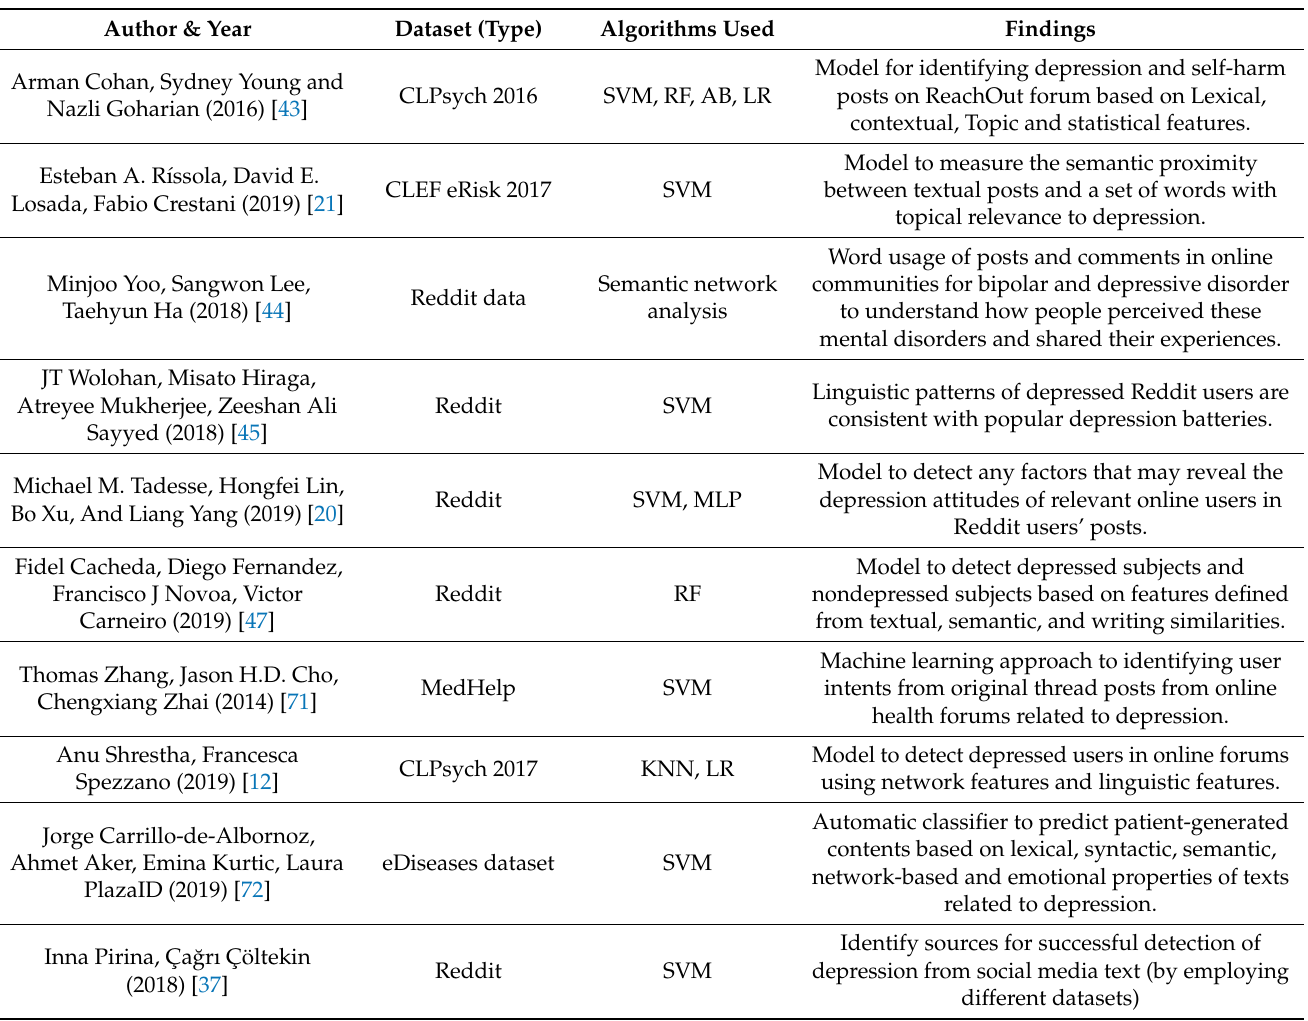
Table 2. Matrix of the summary of findings in depression identification using online support forum data; Moreover similar techniques were applied when analysing online forum textual contexts (Support Vector Machines = SVM, Logistic Regression = LR, Random Forest = RF, Ada Boosting = AB, Multinomial Naive Bayes = MNB, K-nearest neighbor = KNN, Passive Aggressive Classifier = PAC, Stochastic Gradient Descent = SGD, Neural Network = LSTM, Multi- layer Perceptron = MLP, Conventional Neural Network = CNN, Long Short Term Memory = LSTM, Gradient Boosting = GB, Bagging Predictors = BP, Bidirectional Long Short-Term Memory = BiLSTM, Multi-Gated LeakyReLU CNN = MGL-CNN, Bi-directional Encoder Representation Transformer = BERT, Generative Pretrained Transformer =